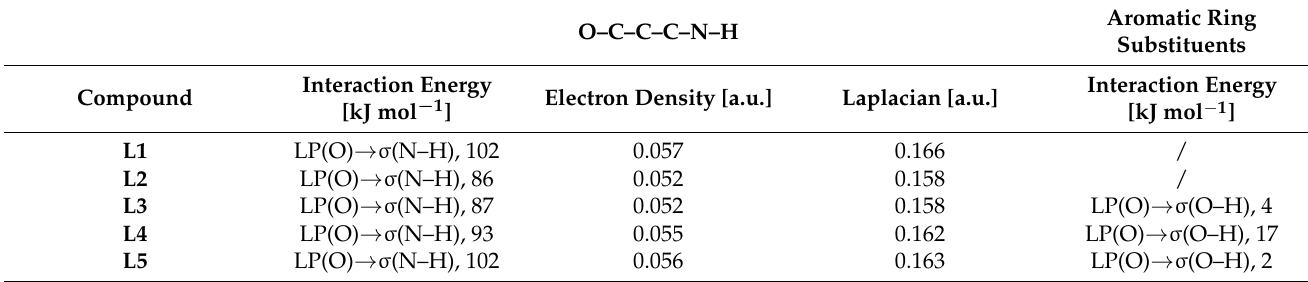
Table 4. The interaction energies, electron density, and Laplacian of the intramolecular